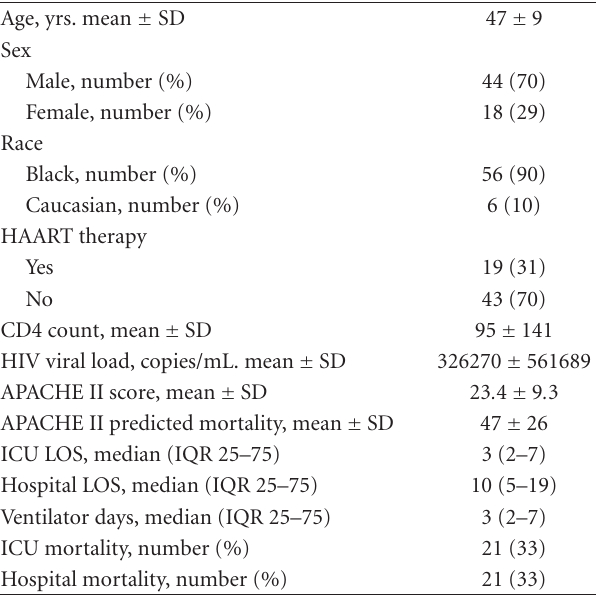
Table 1: Demographics, length of stay, and mortality.